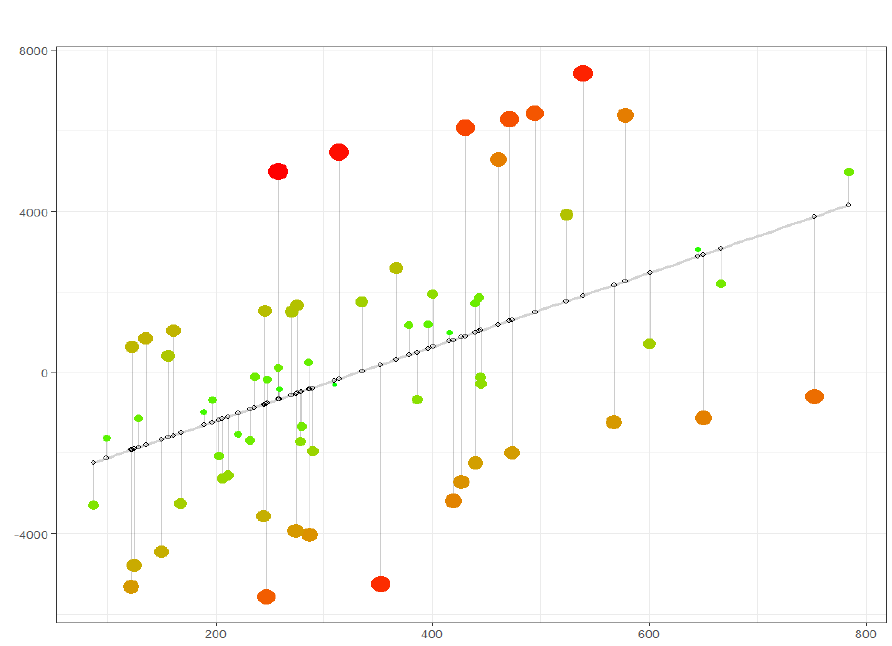
Fig. 1. OLS regression line for all farms with 0.1 ha of farmland on the x-axis, and included and depreciation period 30 years on the y-axis. Each dot represents a farm, and the size indicates the deviation from the regression line. The vertical lines are the projections onto the